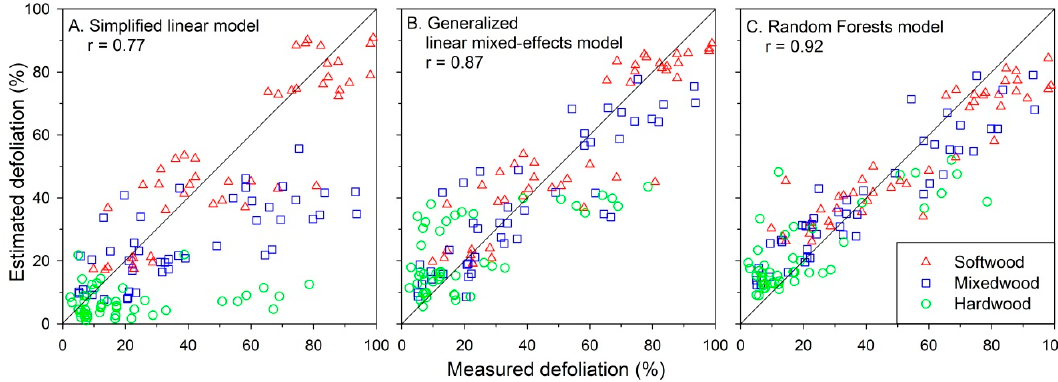
Figure 4. Annual plot defoliation, estimated with: ( A ) the simplified linear model (Equation (1)); ( B ) a generalized linear mixed-effects model; and ( C ) the Random Forests model, plotted against measured defoliation for 27 plots each year from 2012 to 2016.